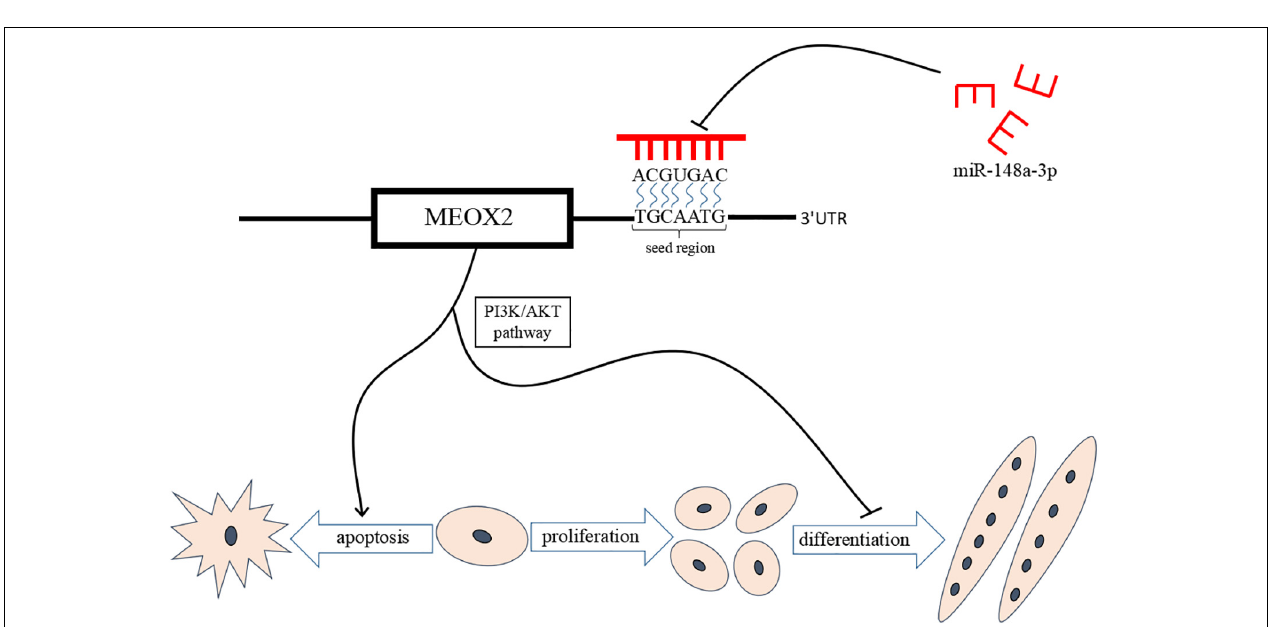
FIGURE 10 | miR-148a-3p-mediated skeletal muscle satellite cell regulatory pathway model. miR-148a-3p activates the PI3K/AKT pathway by directly inhibiting Meox2 expression, and then miR-148a-3p promotes differentiation of SMSCs and inhibits apoptosis of SMSCs by inhibiting Meox2.